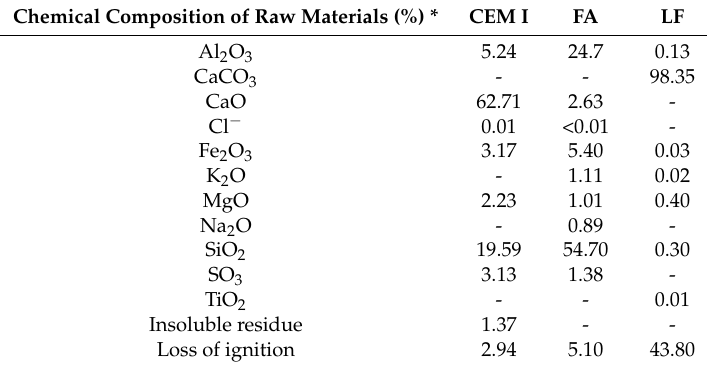
Table 4. Chemical composition of the raw